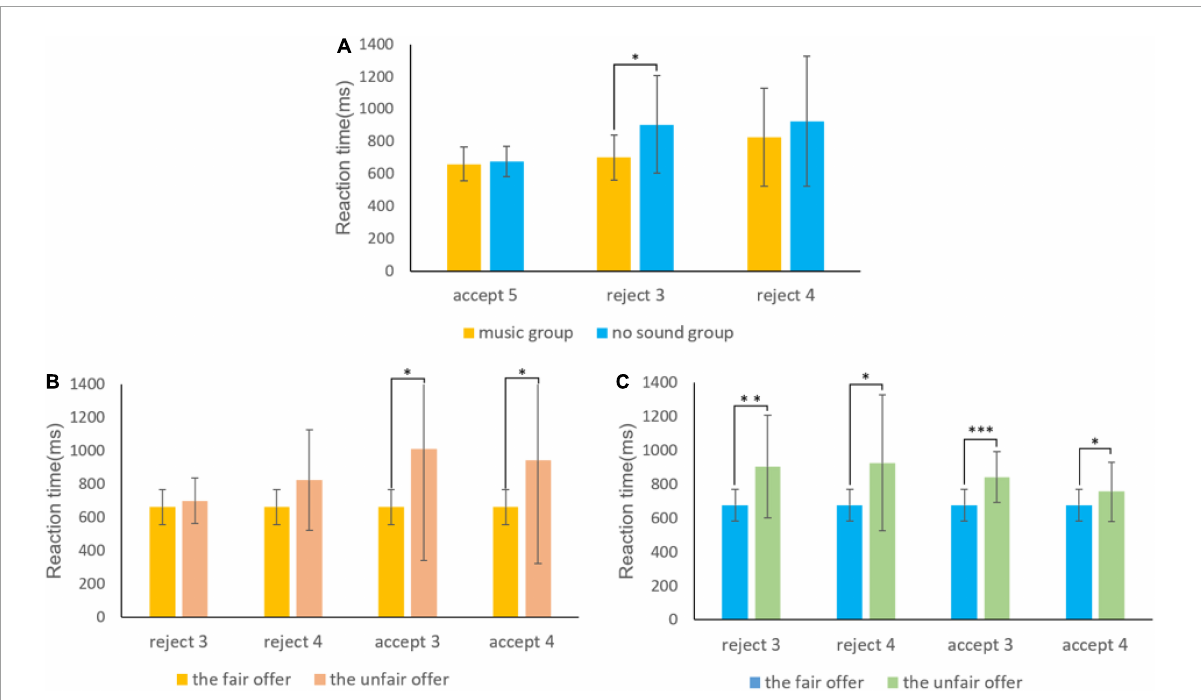
FIGURE2 Reaction time in different conditions. Panel (A) shows there were no significant differences between the music group and no sound group when accepting the fair offer of 5, and the music group have a shorter reaction time for rejecting an unfair offer than the no sound group when rejecting the moderately unfair offer 3 and 4. Panel (B) shows there were no significant differences when rejecting the unfair offer of 3 and 4 than accepting the fair offer of 5 in the music group, but there were significant differences when accepting the unfair offer of 3 and 4. Panel (C) shows the no sound group need significantly longer reaction time when rejecting or accepting the unfair offer of 3 and 4 than accepting the fair offer of 5. ( ∗ p < 0.05, ∗∗ p < 0.01, ∗∗∗ p <